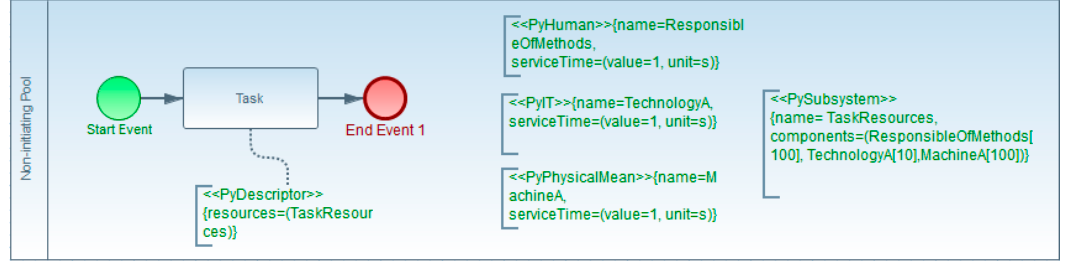
Figure 5. Example of text annotation used for each task.